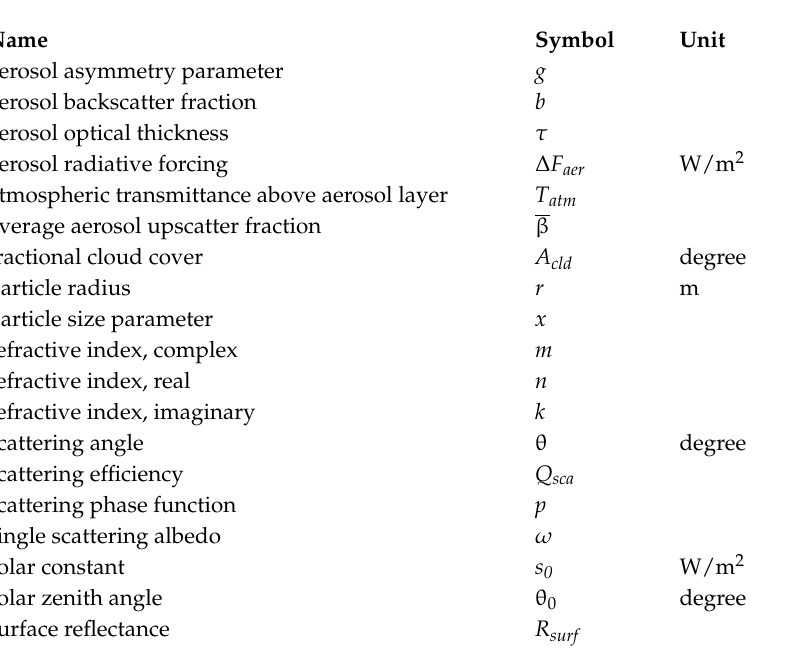
Symbols Symbols used together with common units. If the unit field is blank, the quantity has the unit one (also known as